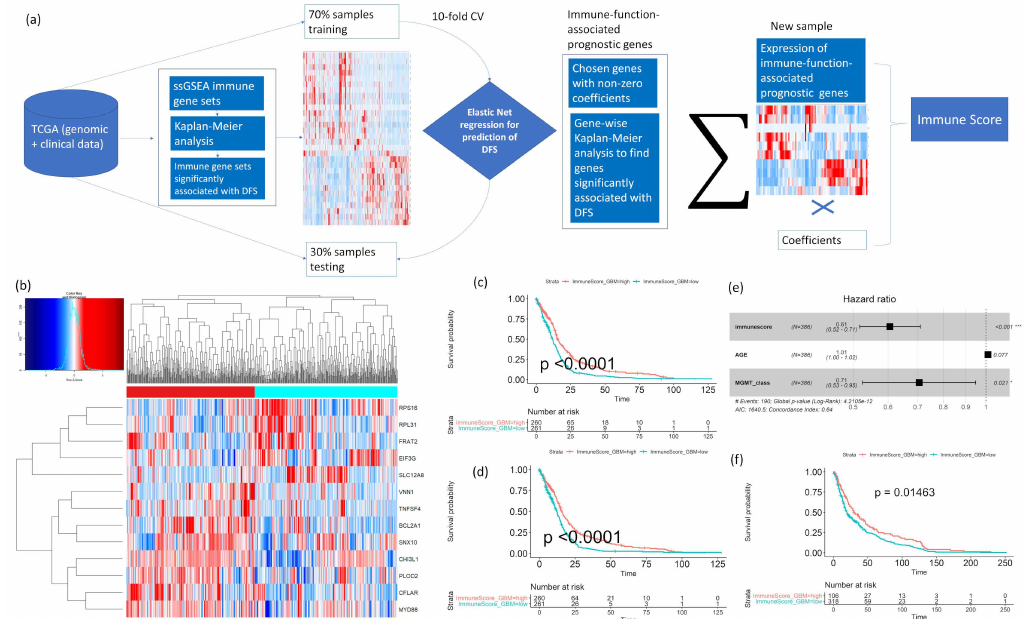
Figure 4. ( a ) The workflow for identifying immune-function-related prognostic genes and calculating a combined prognostic immune score for each TCGA cancer type is shown. For a given cancer type, ssGSEA is performed on the 61 curated immune gene sets, and Kaplan–Meier analysis is performed to reveal sets that significantly stratify patients into better or worse DFS based on the median ssGSEA score. To determine the minimum set of genes with prognostic significance, the genes associated with these filtered immune gene sets are pulled out and undergo expression modeling by an elastic net, enabling us to shortlist genes positively or negatively associated with DFS length. The elastic net model is trained on 70% of the samples from that cancer type and tested on the remaining 30%. Univariate Kaplan–Meier analysis is performed on the filtered genes from the elastic net (with non-zero coe ffi cients) to further diminish the number of genes used in the final model for calculating the combined immune score for the cancer type. The score is calculated by the sum of the expressions of the selected genes, weighted by their respective elastic net coe ffi cients. ( b ) Thirteen immune-signature-associated genes that were identified from the elastic net, and univariate Kaplan–Meier analysis stratified TCGA GBM patients into two distinct clusters. ( c , d ) The immune score calculated from these 13 genes stratified TCGA GBM patients into better or worse prognostic groups for ( c ) DFS and ( d ) OS. p -value was calculated using Kaplan–Meier analysis. ( e ) In multivariate Cox regression analysis, immune score remains an independent predictor of DFS in GBM (TCGA cohort), along with age and MGMT methylation status. ( f ) The GBM immune score model using 13 prognostic genes significantly stratifies patients into better or worse prognostic groups in an independent validation cohort from the REMBRANDT